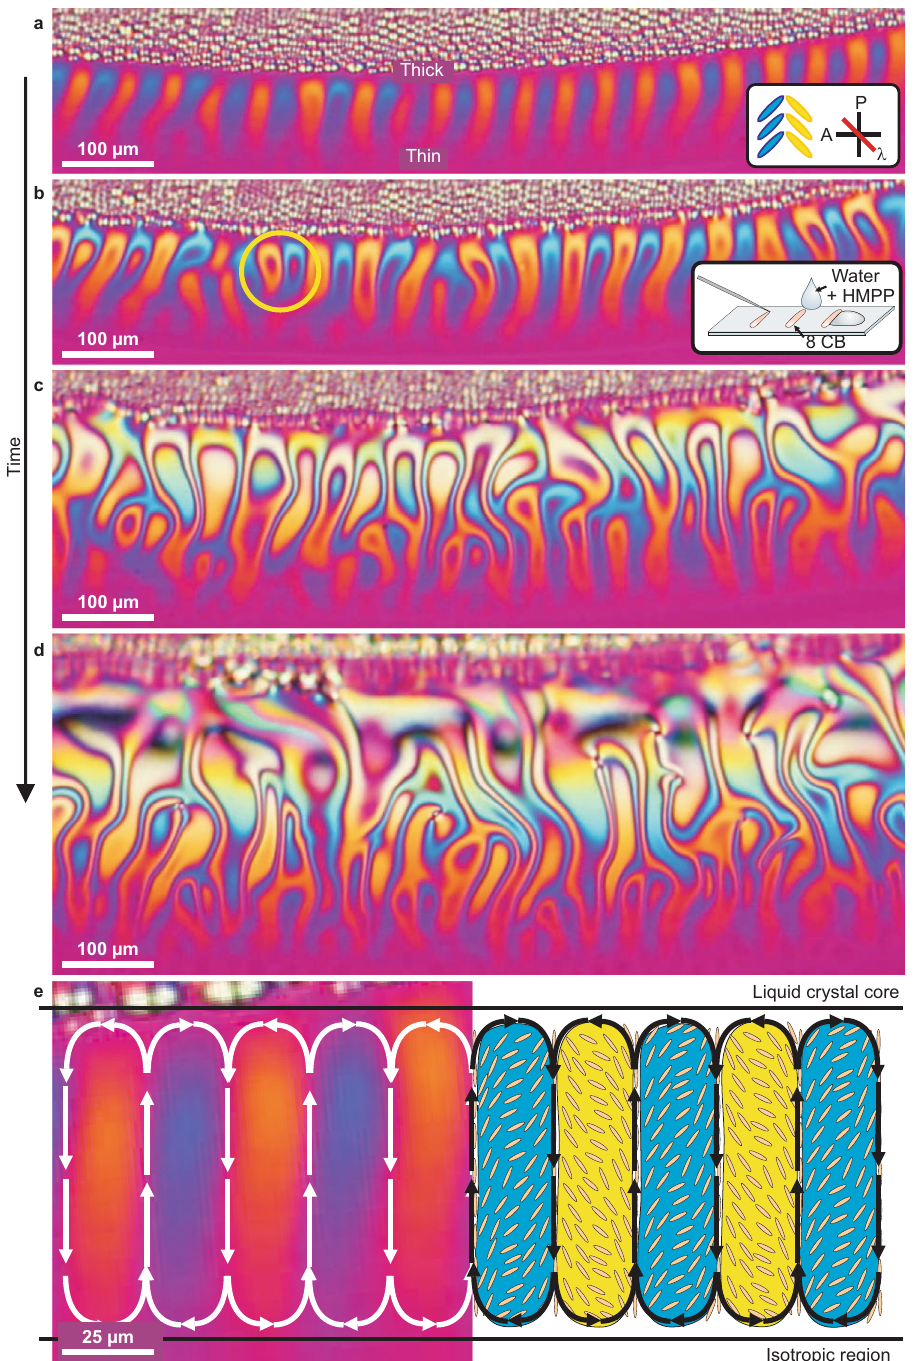
Fig. 3 | Development of turbulence in a thin hybrid nematic layer. a In the thin hybrid liquid crystal (LC) fi lm the director gradually (after ~2min) develops a periodic domain con fi guration, where blue and yellow regions correspond to areas where the nematic LC molecules are tilted in opposite directions with respect to the polarizers (as schematically shown in the inset). The blue and yellow regions hence represent two domains of the the herringbone-like pattern, shown in the inset. b Later, islands of opposite orientations are seen to emerge within the primary domains. The inset shows a changed experimental setting. HMPP - 2-hydroxy-2-methylpropiophenone photoinitiator. c The LC fi lm thickens with time, resulting in a broader range of colors corresponding to higher orders of retardation. Islands within islands of the same color can be observed. The